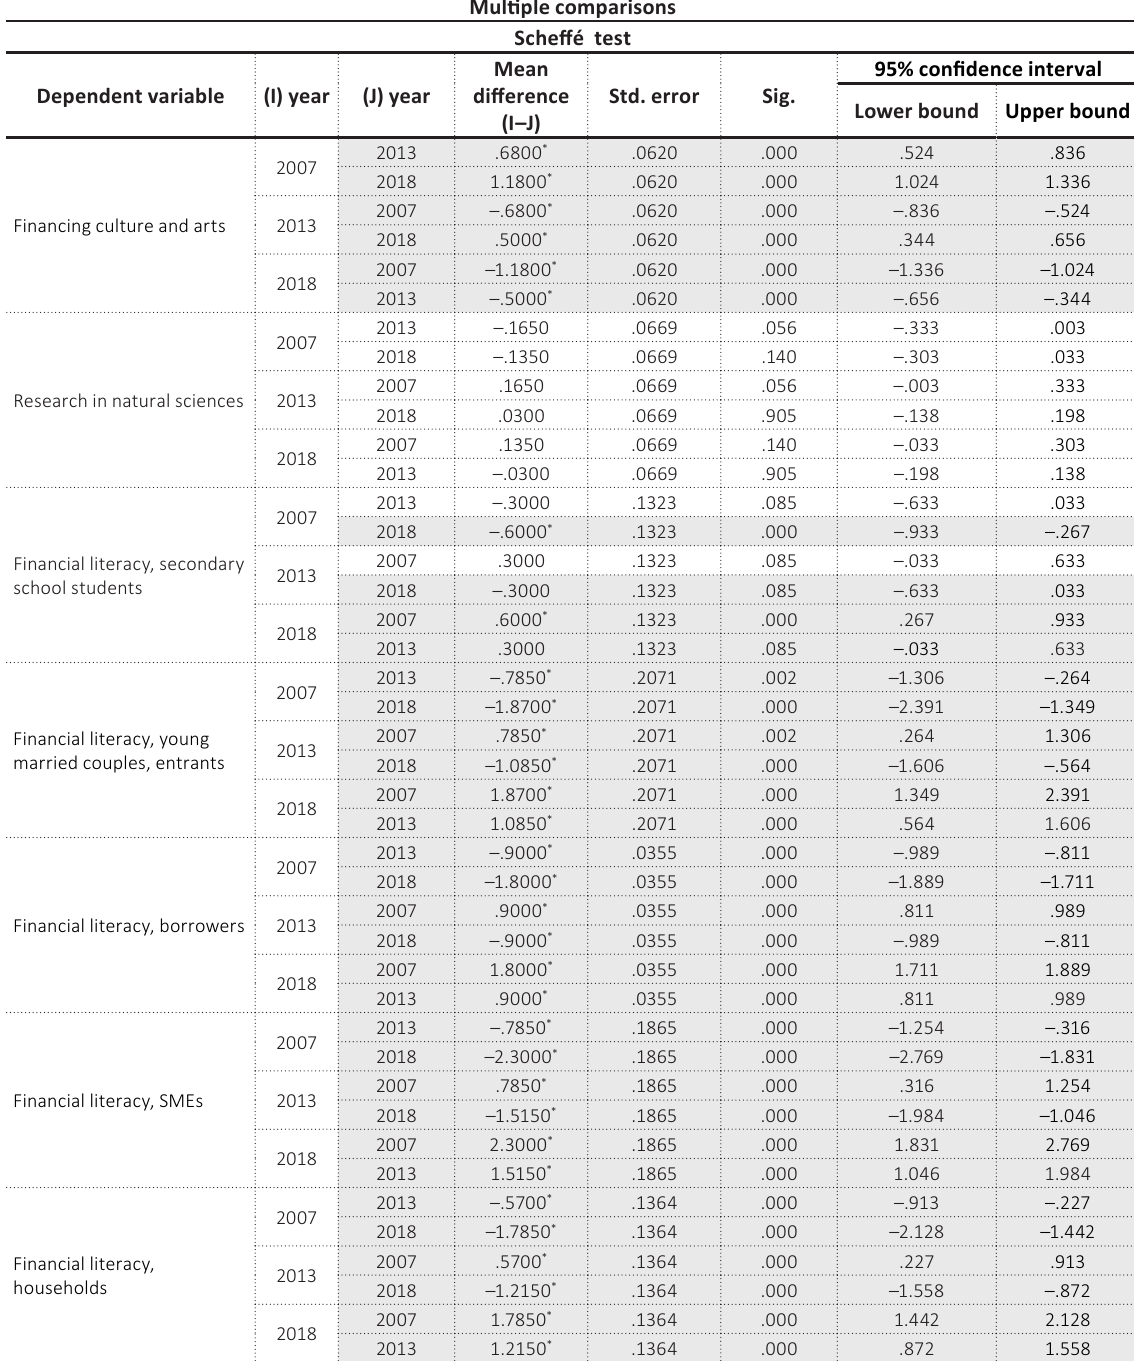
Table 5 (cont.). Scheffé test